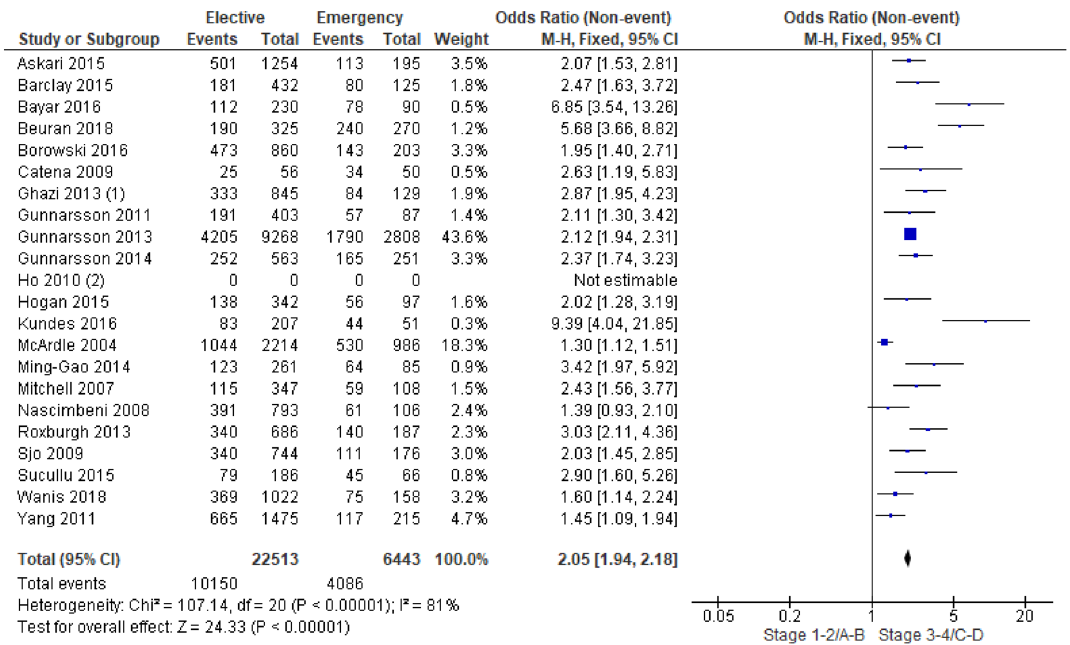
Figure 4. Association between overall tumour staging and emergency presentation—Forest